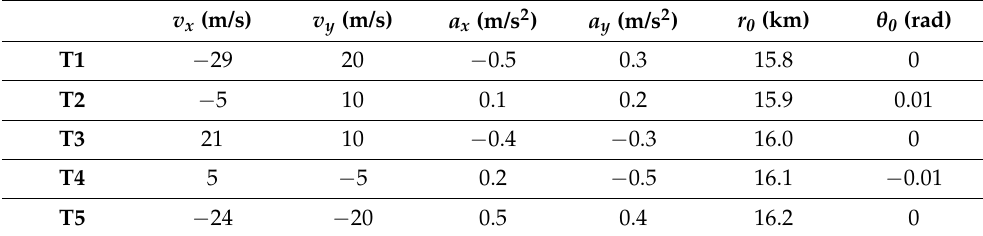
Table 3. Parameters of the moving